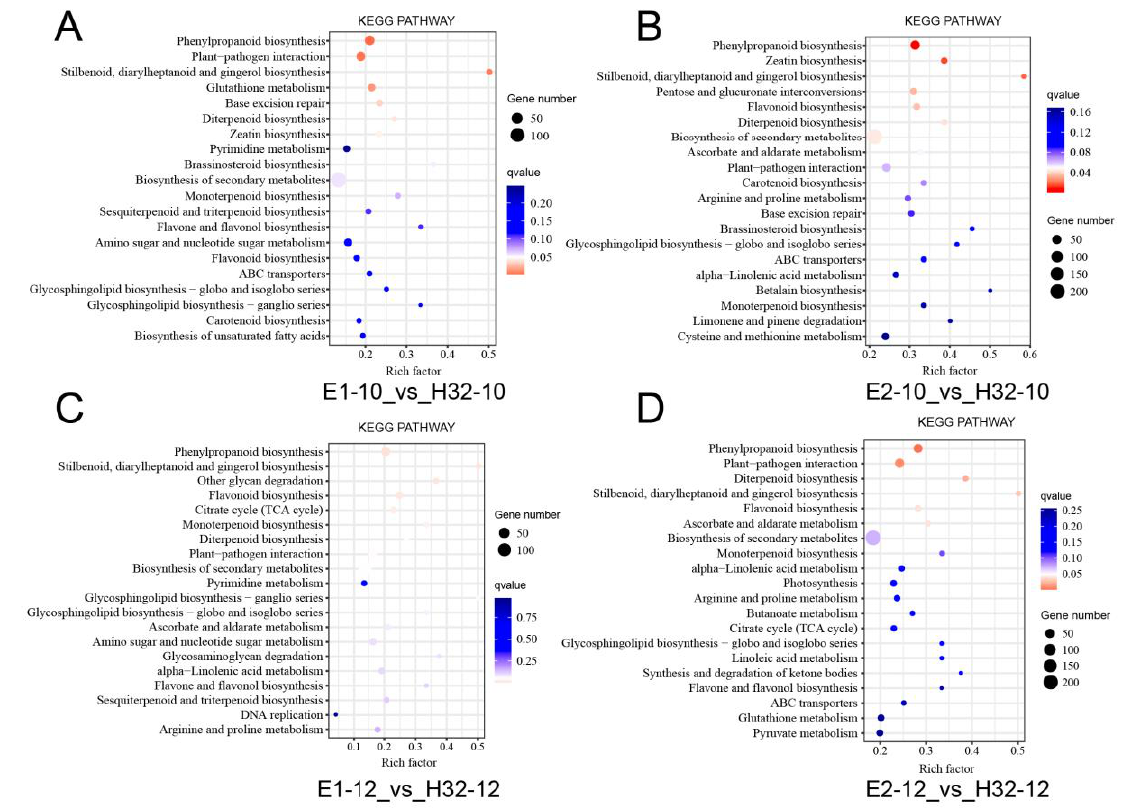
Figure 4. KEGG (Kyoto Encyclopedia of Genes and Genomes Pathway) analysis of DEGs. ( A ) GO map of DEGs in E1-10_vs_H32-10; ( B ) GO map of DEGs in E1-12_vs_H32-12; ( C ) GO map of DEGs in E2-10_vs_H32-10; ( D ) GO map of DEGs in E2-12_vs_H32-12. y-axis represents the pathname, and the x-axis represents the enrichment factor. The larger the enrichment factor, the higher the enrichment level of DGEs in the pathway. The p value is expressed by color with white as the border. The deeper the red color, the more important the accumulation of DEGs in the signaling pathway. The number of DEGs in a pathway was expressed by the size of the circle. The larger the circle, the higher the enrichment of the pathway. Table 3. Important genes related to chloroplasts and